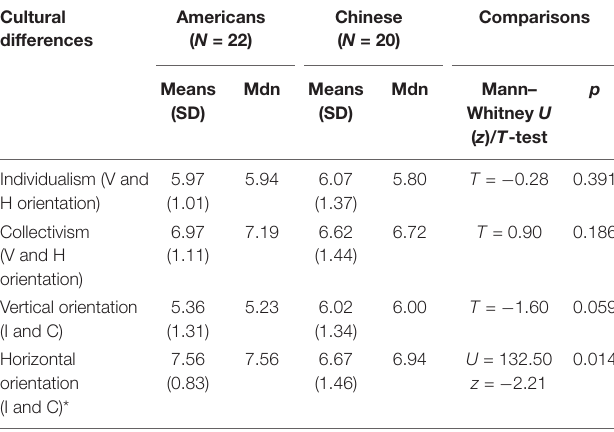
TABLE 4 | Statistics of cultural differences: Combined factors.